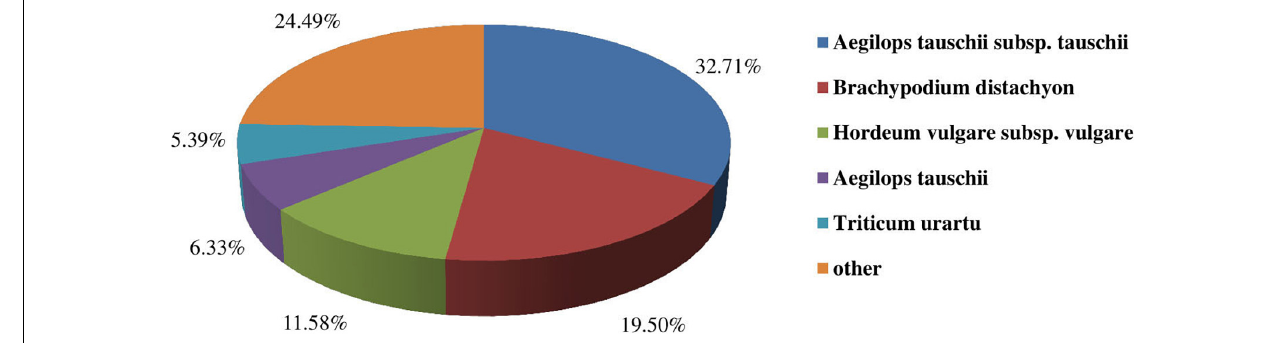
FIGURE 3 | Similarities of Oats to other